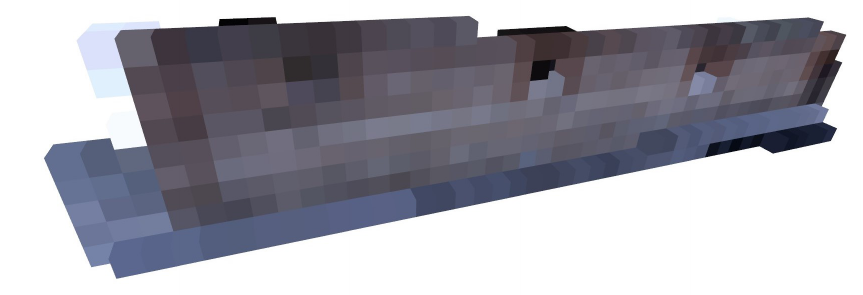
Figure 17. Voxelization with a voxel size of 50